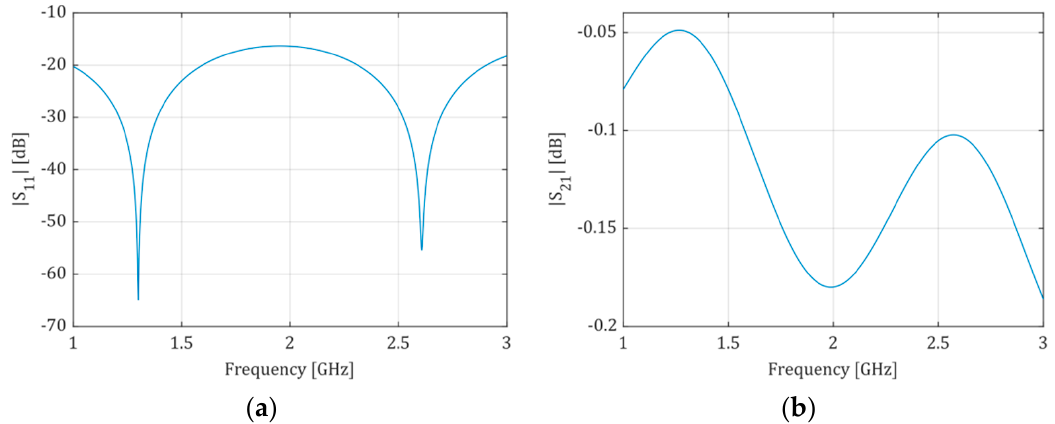
Figure 3. Scattering parameters obtained from simulation of the short-channel LTCC module: ( a )—magnitude of S 11 ( S 22 ), ( b )—magnitude of S 21 ( S 12 ). The structure is electrically